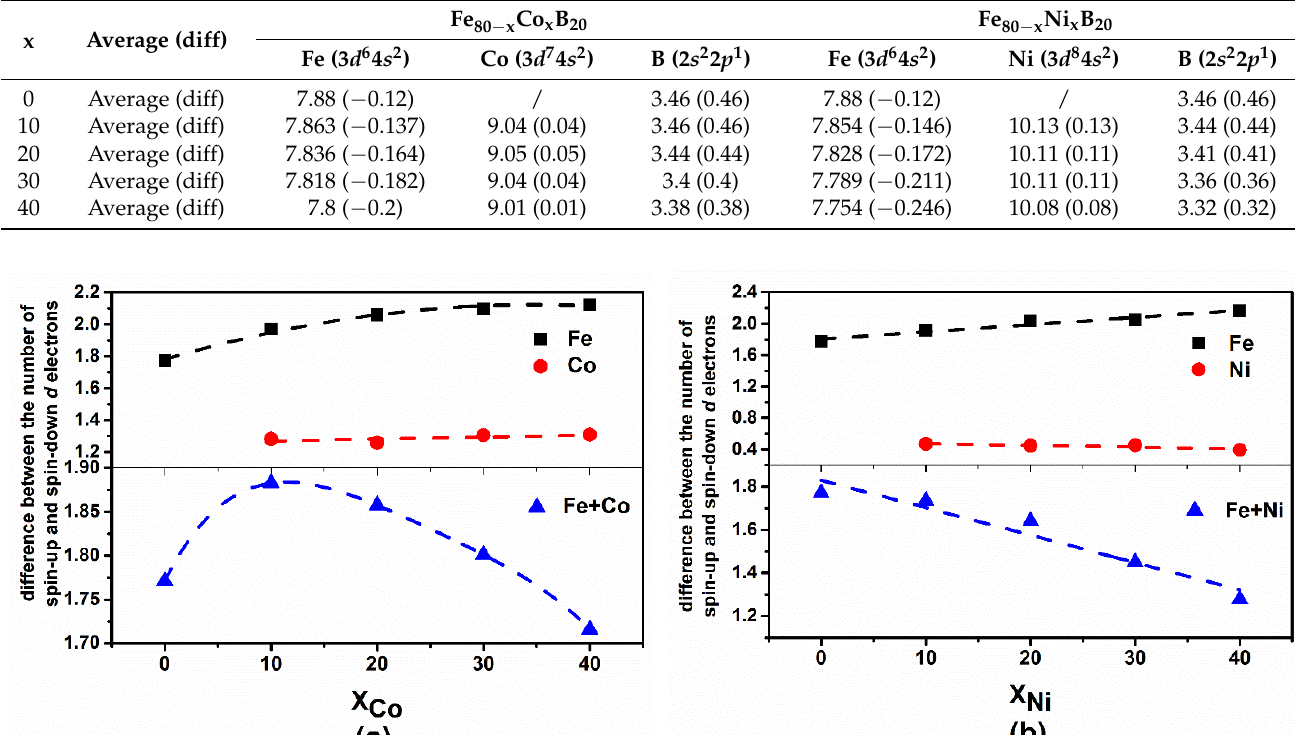
Figure 5. Difference between the number of spin-up and spin-down d electrons of ( a ) Fe 80 − x Co x B 20 and ( b ) Fe 80 − x Ni x B 20 (x = 0, 10, 20, 30, and 40 at.%) amorphous alloys. The dashed lines represent the fitted curves.